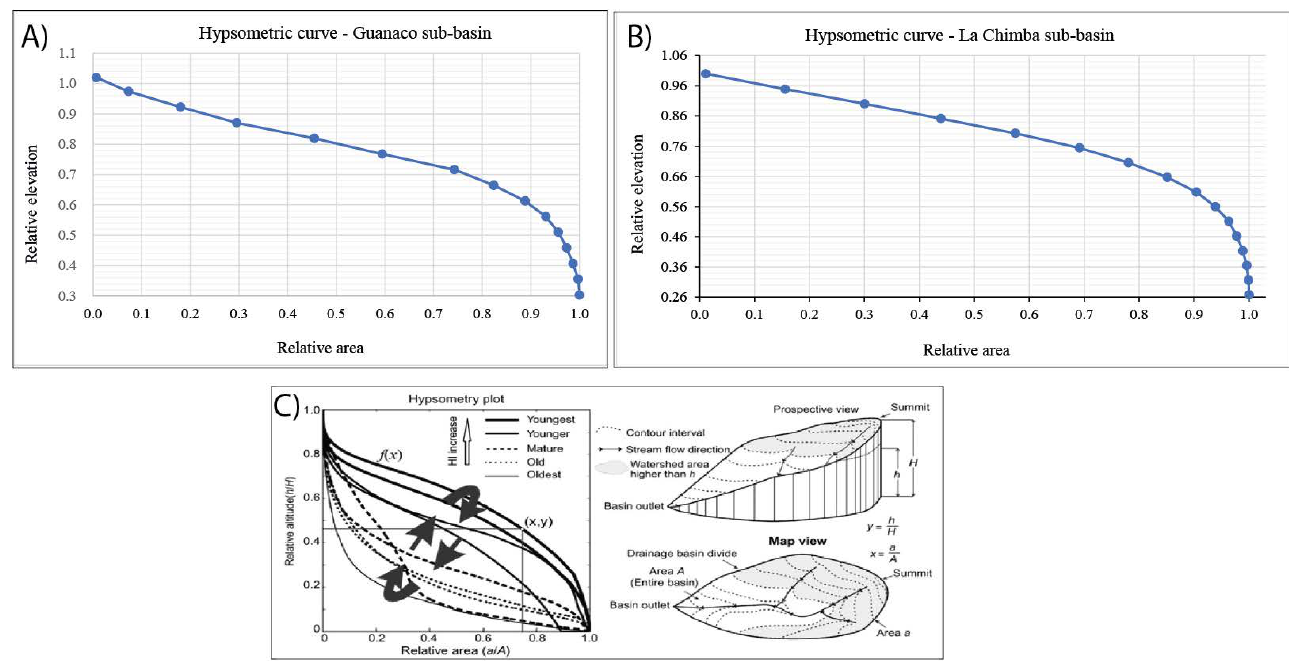
Figure 10. La Chimba basin hypsometric curve. ( A ) Guanaco sub-basin hypsometric curve. ( B ) La Chimba sub-basin hypsometric curve. ( C ) The result interpretation is based on a comparative curves resulting from the Strahler [57] methodology, in Liem and Bui